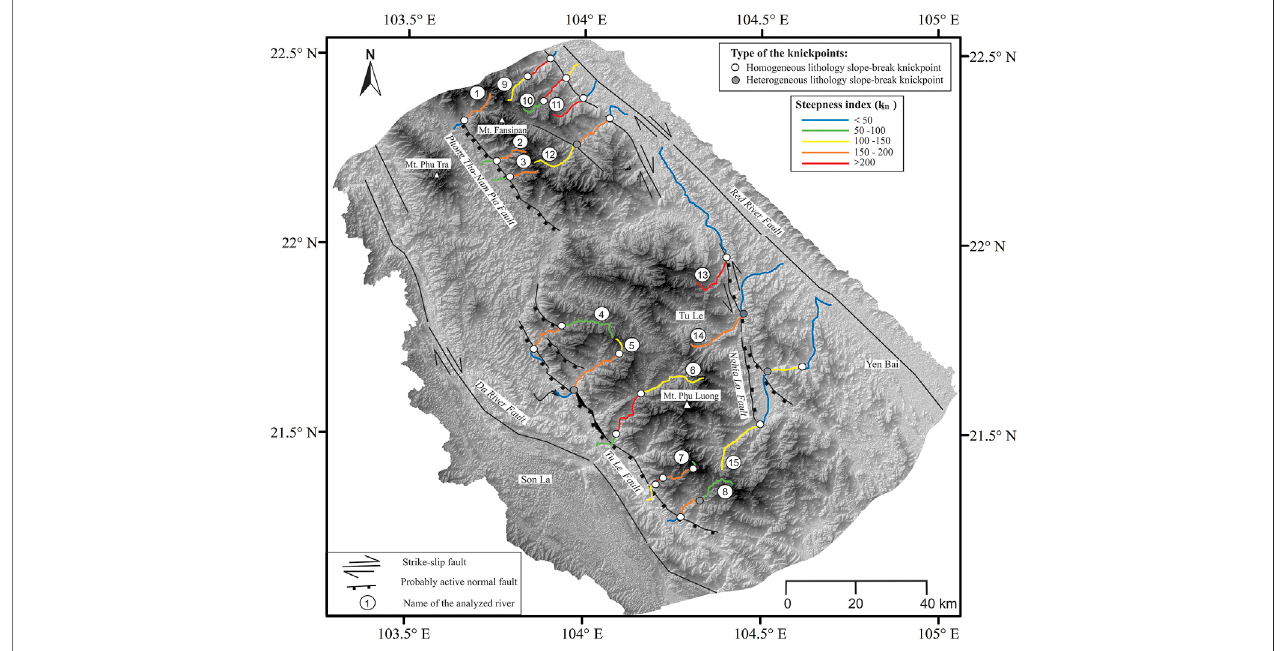
FIGURE 12 | Topographic map showing distribution of the knickpoints as identi fi ed in Figure 11 and the normalized steepness index (k sn ) values along the analyzed rivers. The values of k sn are indicated by different colors, corresponding to k sn color scale in Figure 11 .